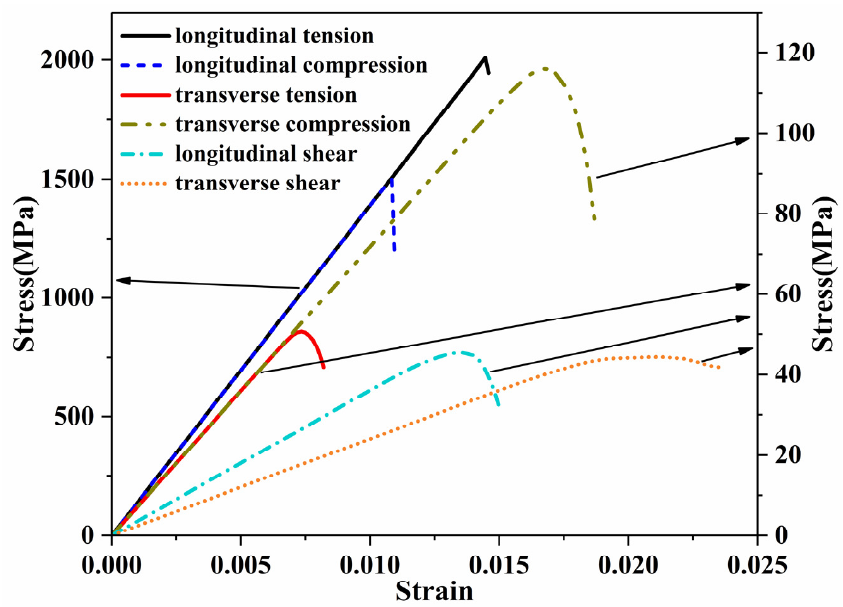
Figure 7. Typical stress–strain curves of unidirectional composite (3% void content) under different uniaxial loadings.